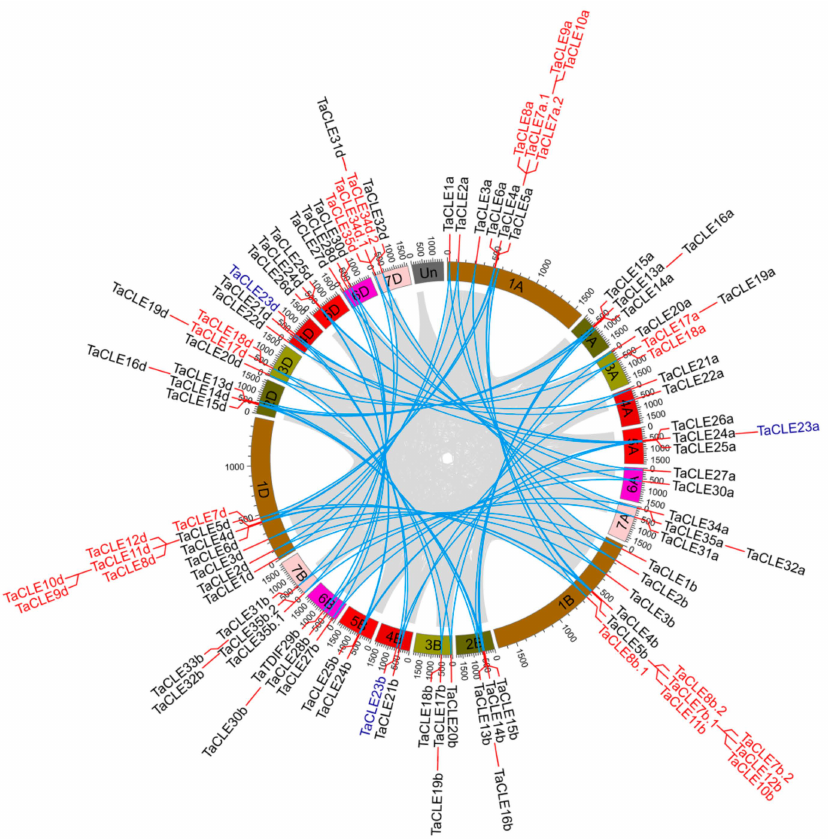
Figure 2. Mapping of duplicated TaCLE genes on wheat chromosomes. Light gray shading represents a collinear relationship among the blocks in whole genome and the deep sky-blue lines represent the collinearity of the TaCLE genes. The red lines indicate that there was a collinear relationship among the tandemly duplicated genes. The red fonts indicate tandem duplication genes. The blue fonts indicate the chromosome distribution of TaCLE23a , TaCLE23b and TaCLE23d